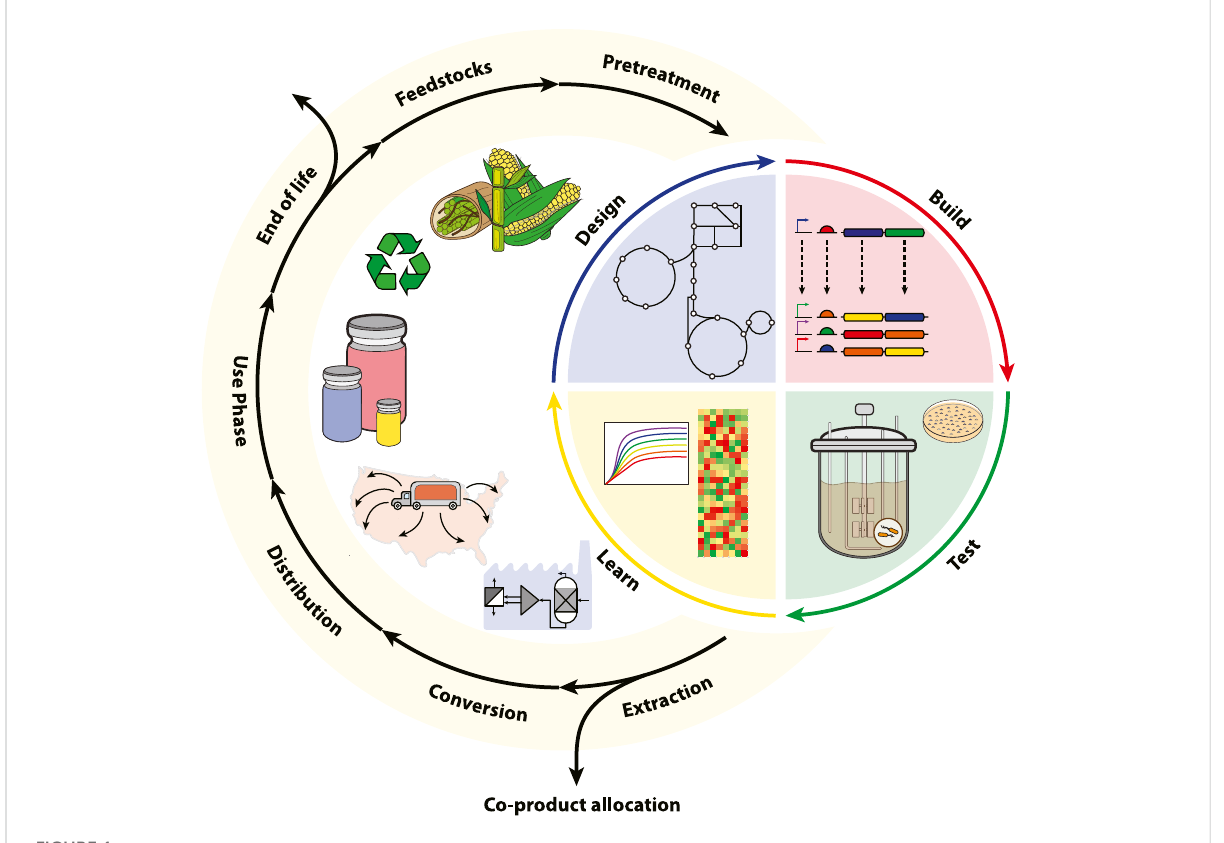
FIGURE 1 The integration of LCA and synthetic biology within a circular bioeconomy. Here, the LCA framework is subdivided into the cradle-to-grave stages of raw material acquisition (feedstocks and pretreatment), manufacturing (DBTL, extraction, and conversion), distribution, use-phase, and end-of-life. For bioproduction platforms, extraction may be further subdivided into bioseparation and media recycling with co-product allocation also accounting for biological waste treatment. Synthetic biology is represented by the DBTL cycle and integrated into the core manufacturing stage of the LCA. The framework enables iterative benchmarking for scaling bioproduction according